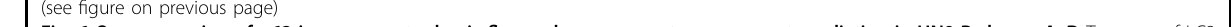
Fig. 6 Overexpression of p62 increases autophagic fl ux and senescence to responses to radiation in HN9-R clones. A – D Turnover of LC3 over time after irradiation (IR) at 4 Gy ( A , C ) and accumulated amounts of LC3-II at 24 h after 4 Gy of IR in the presence of ba fi lomycin-A1 (Baf A1, 1 nM, 4 h; B , D ) in HN9-S vs HN9-R clones ( A , B ) or vector control vs p62-overexpressed HN9-R clones ( C , D ) analyzed by immunoblotting. In B and D , the relative ratio of LC3-II to β -actin was used as an indicator of autophagic fl ux, which was calculated by comparing the cells treated with IR and Baf A1 to that with IR only. Results are presented as means ± standard error of the mean (SEM). Western blots are representative of three independent experiments. E Measurement of autophagic fl ux by mRFP-EGFP/MAP1LC3B puncta assay to irradiation (4 Gy, 6 h) after pretreatment of Baf A1 (10 nM, 1 h) in vector control and p62-overexpressed HN9-R clones. Graph represents quanti fi cation of RFP-positive, GFP-positive autophagosomes (yellow puncta) and RFP-positive, GFP-negative autolysosomes (red puncta). Scale bars, 20 μ m in GFP image and 10 μ m in magni fi ed image. F , G Clonogenic survival ( F ) and percentage of cells positive for senescence-associated beta-galactosidase (SA- β -gal) staining of p62-overexpressed HN9-R after irradiation of 4 Gy ( G ). All results were obtained from at least three independent experiments. Results are presented as means ± standard error of the mean (SEM). * p < 0.05; ** p < 0.01; *** p <